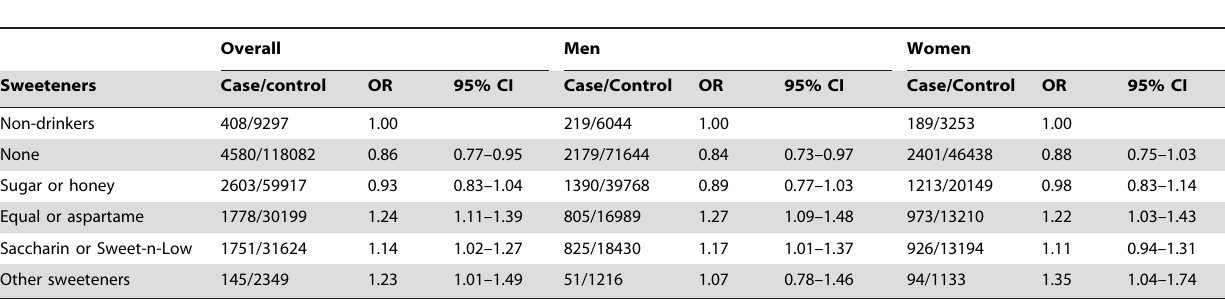
Table 5. Odds ratios a and 95% confidence intervals of depression according to types of sweetener added to coffee or tea in the NIH-AARP Diet and Health Study, 1995–2006.